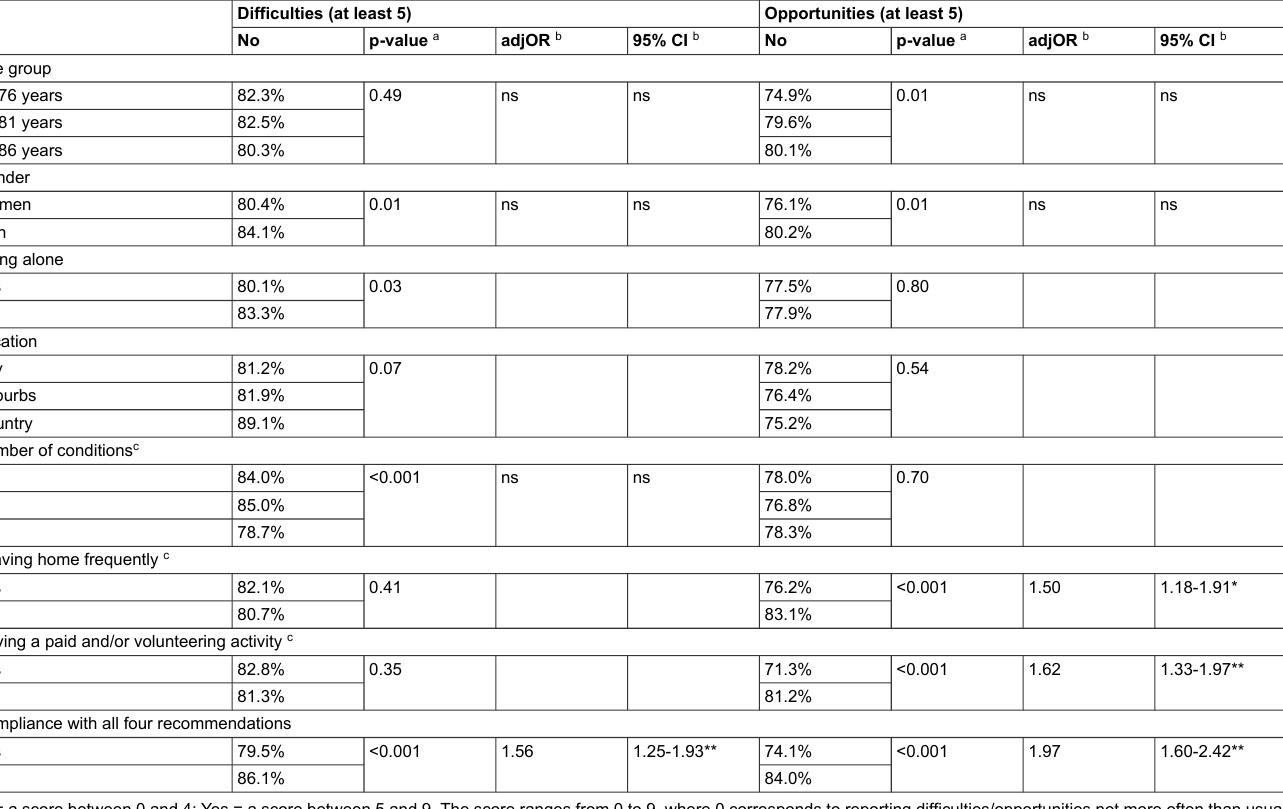
Table 6: Results from bivariable and multivariable analyses examining factors associated with the impact of the partial lockdown on the daily life of